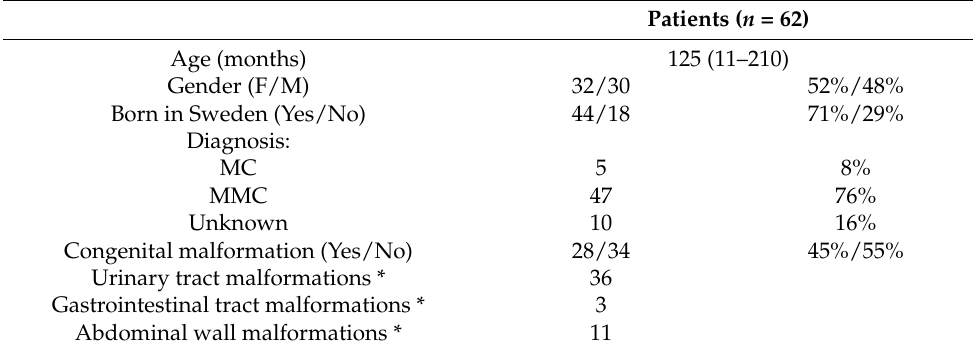
Table 1. Demographics and congenital malformations of 62 patients with spina bifida.